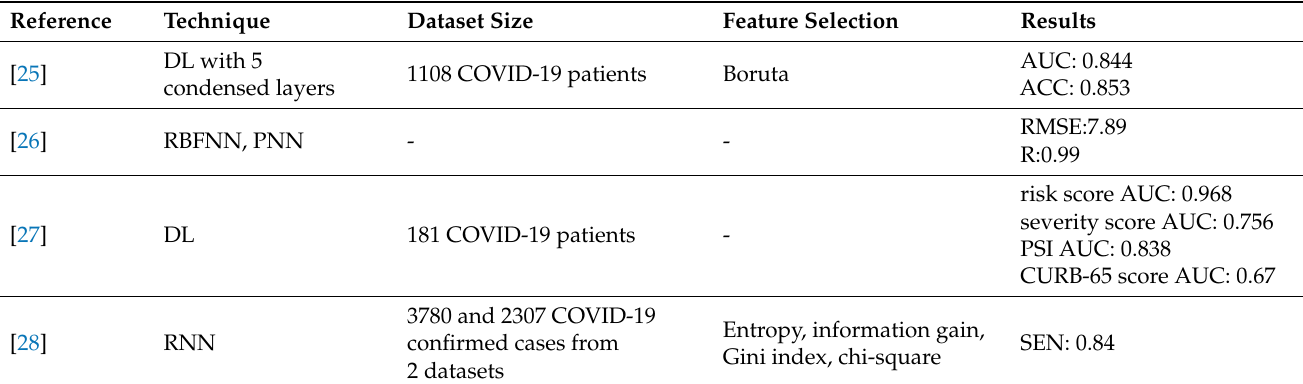
Table 2 contains a summary of related studies using Deep Learning models. Table 2. Summary of the related studies using Deep Learning